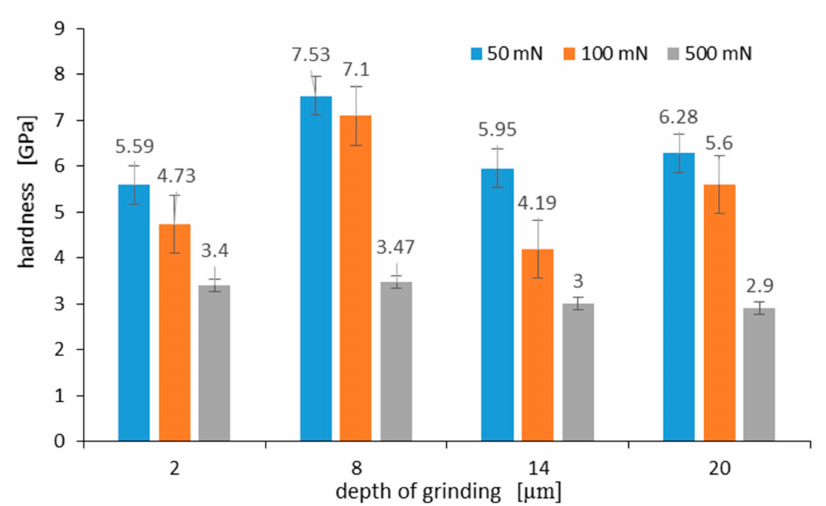
Figure 13. Hardness measured on C45 steel surface at various maximum loads after grinding to a depth of: 2 µ m, 8 µ m, 14 µ m, and 20 µ m. Error bars show ± standard